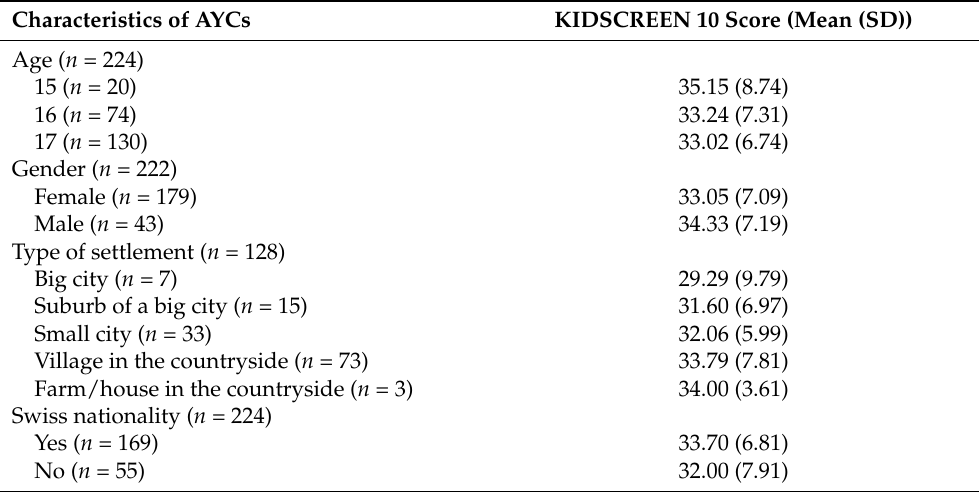
Table 2. Comparison of the mean KIDSCREEN 10 scores (SD) of the AYCs based on age, gender, type of settlement, and